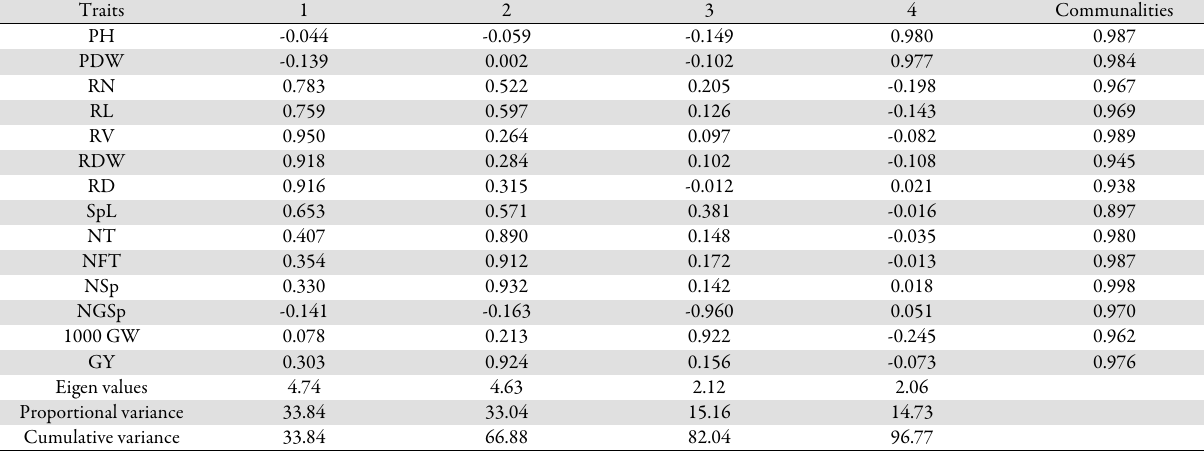
Table 4. Factor analysis for agro-morphological traits in spring wheat cultivars under normal irrigation